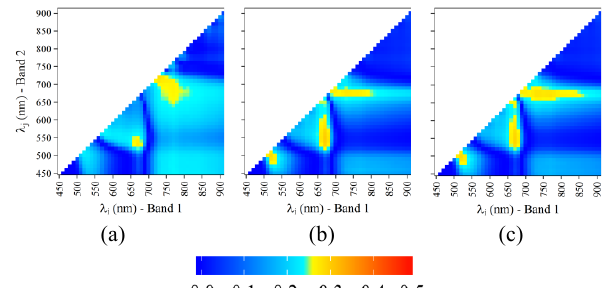
Figure 1. B-dist. for combinations of bands using DI (a), RI (b) and NDI (c).